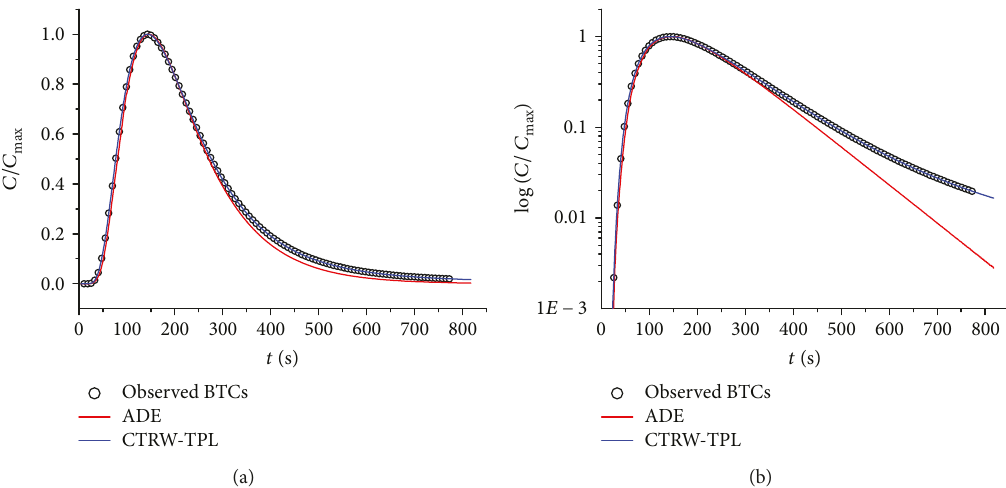
Figure 7: Comparison of ADE and TPL when v = 6 7 × 10 − 2 m/s : (a) normal coordinate system; (b) semilog scale coordinate system.